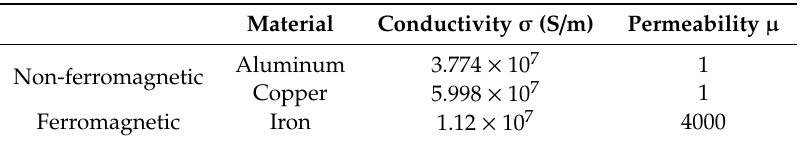
Table 1. Parameters of the